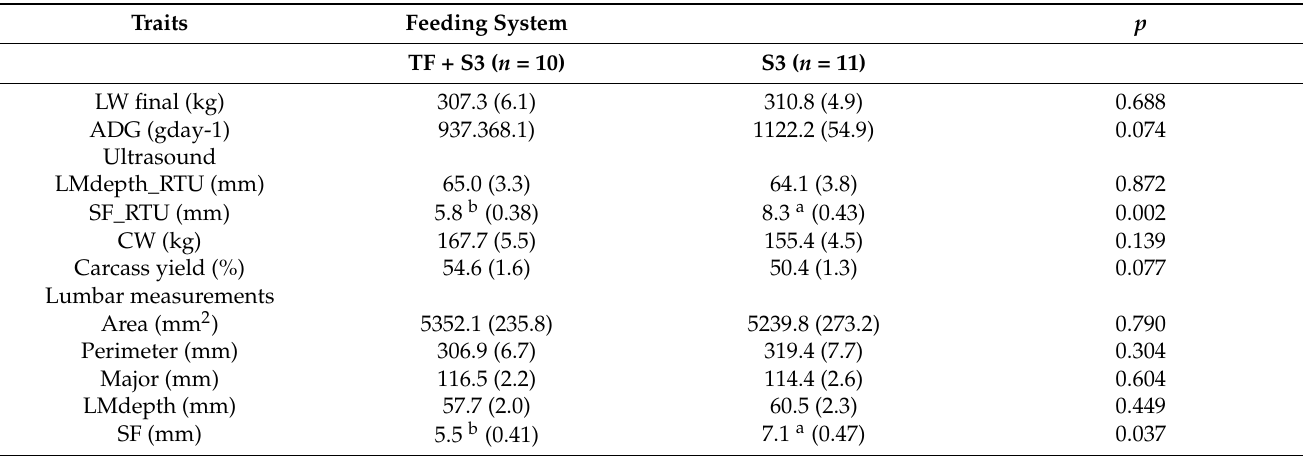
Table 3. Least square means and standard errors (in parenthesis) for live weight, ultrasound mea- surements, carcass weight, and lumbar measurements for steers from TF+S3 and S3 finishing